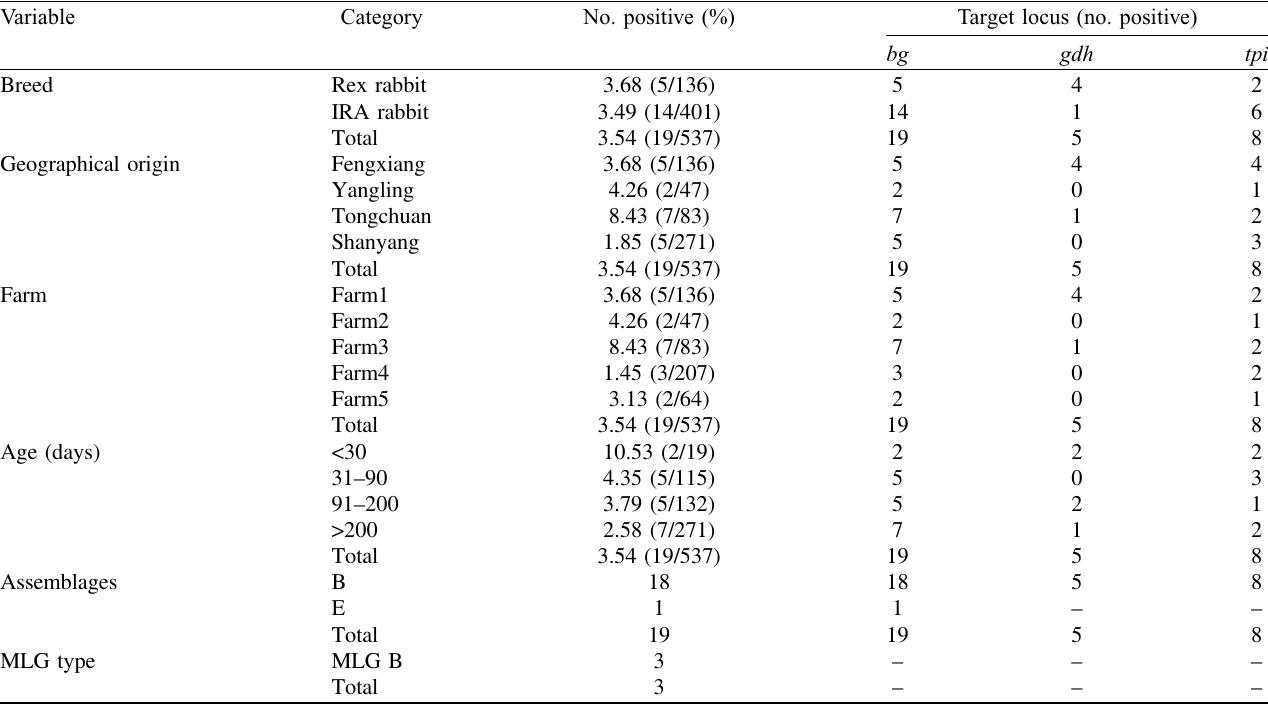
Table 1. Prevalence of Giardia duodenalis infection in rabbits in Shaanxi Province, northwestern China. Variable